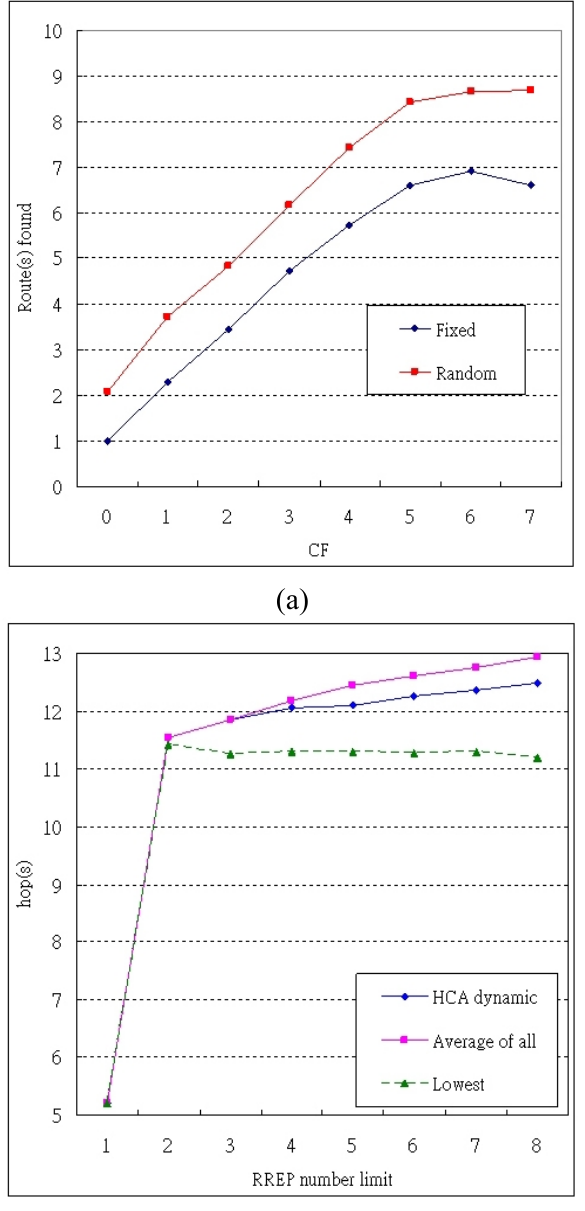
Figure 8. The overhead of MHA in (a) Exp. 3 (b) Exp.